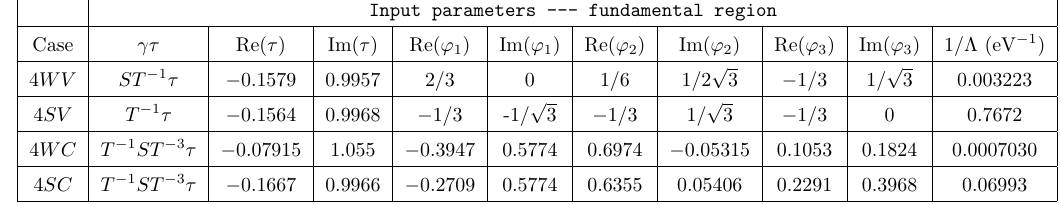
Table 9 . Parameters (cid:28) and ’ in the fundamental region for level 4 models.